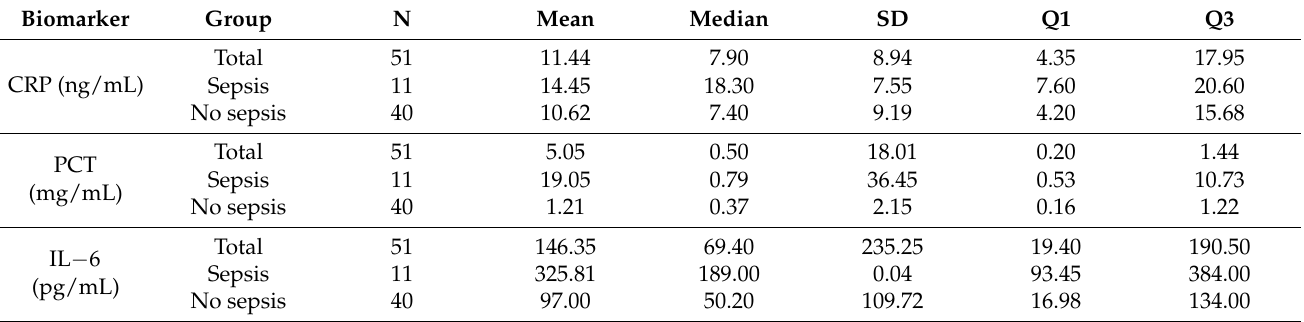
Table 1. A summary statistic of the entire sample and group conditions for the biomarkers. The table shows, from left to right, the following information: “Group”: the group to which the measure belongs (“Total” refers to the entire sample; “Sepsis” refers to those with fever episodes with corresponding documented infections (positive blood, urine or stool culture) and “No sepsis” means without documented infection); “N”: cardinality of the group; “Mean”: the arithmetic mean; “Median”: the arithmetic median; “SD”: standard deviation; “Q1”: first quartile and “Q3”: third